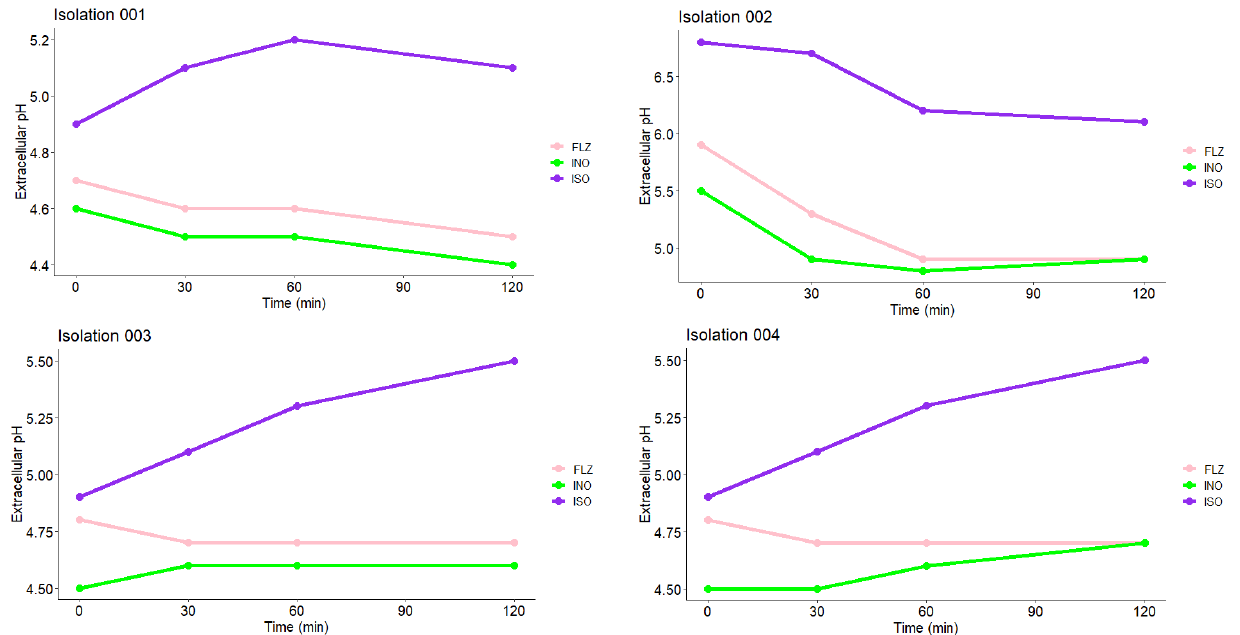
Figure 9. Measurement of extracellular pH of C. tropicalis treated with ISO, FLZ and untreated cells (INO). According to the results obtained by the Kruskal-Wallis test with a value of p = 0.05, there are significant differences between the treatments on the extracellular pH output of the yeasts.